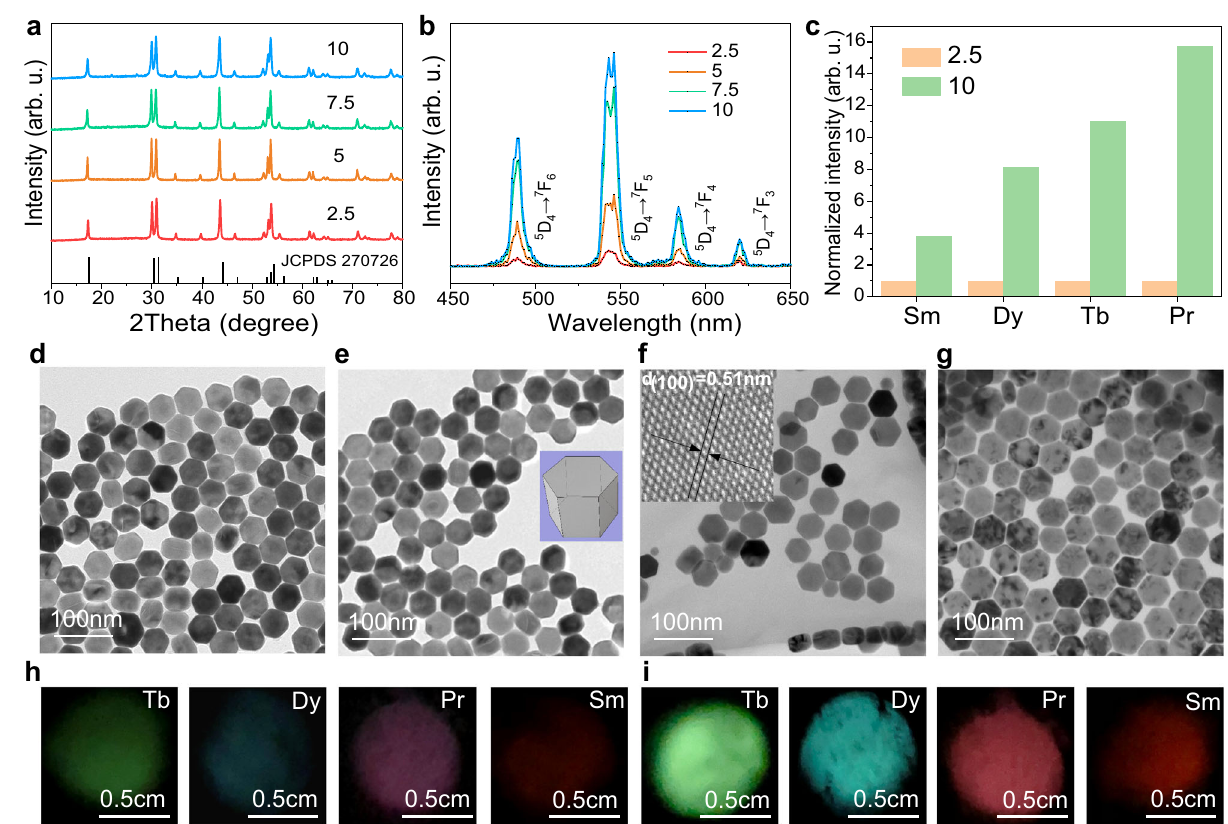
Fig. 2 | Intensi fi cation of XEA via employing excessive Na + precursors. XRD patterns ( a ) and XEA spectra( b ) of the NaLuF 4 : Gd/Tb NPs preparedwith different [Na]/[RE]ratios. c IntegralXEAintensitiesoftheNaLuF 4 :15Gd/(0.5Pr,15Tb,0.5Dyor 0.5Sm)NPspreparedwith[Na]/[RE]of2.5and10.TheXEOLintensitiesforthe[Na]/ [RE]=2.5 were normalized to 1. TEM images of the NaLuF 4 : Gd/Tb NPs prepared